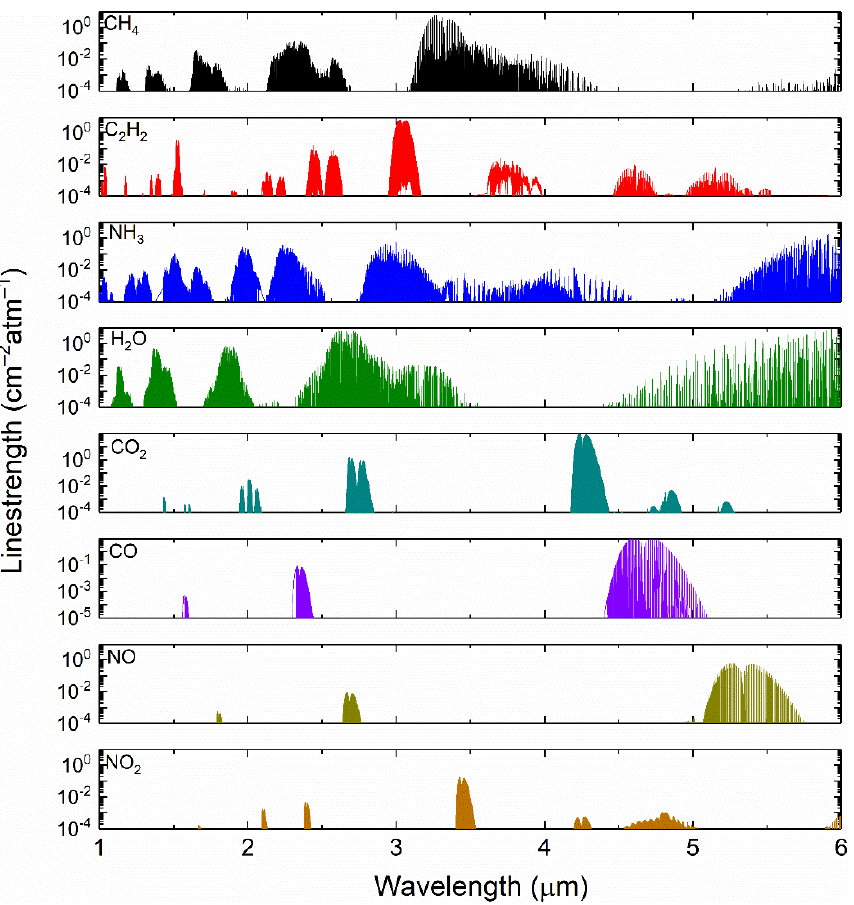
Figure 1. Absorption features of typical exhaust mixtures within near- and mid-infrared region (1– 6 μm) at 296 K based on HITRAN 2020 database [42]. (1–6 µ m) at 296 K based on HITRAN 2020 database